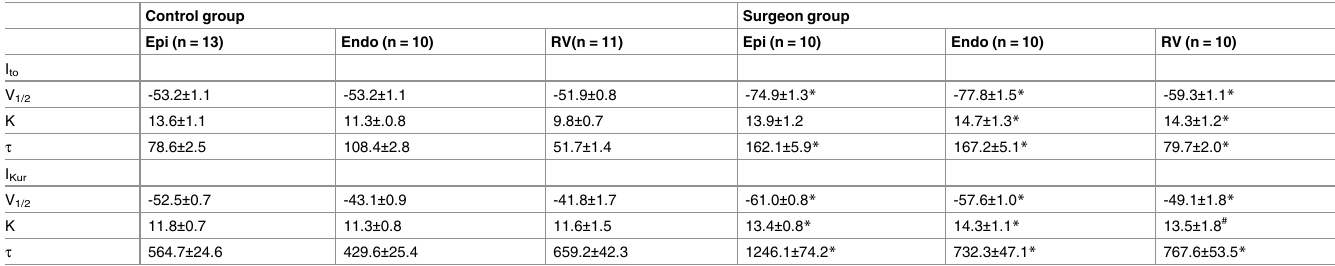
Table 4. Kinetics of I to and I Kur channels.